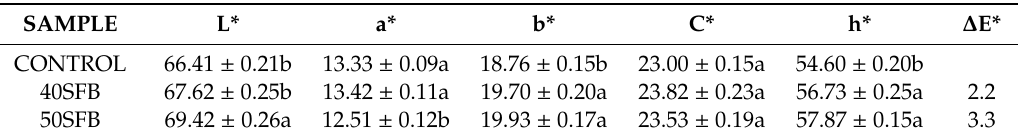
Table 3. Color parameters of chicken sausages with di ff erent substitution level (%) of chicken skin by chicken fatty byproducts (40SFB: 40% substitution of chicken skin by fatty byproducts; 50SFB: 50% substitution of chicken skin by fatty